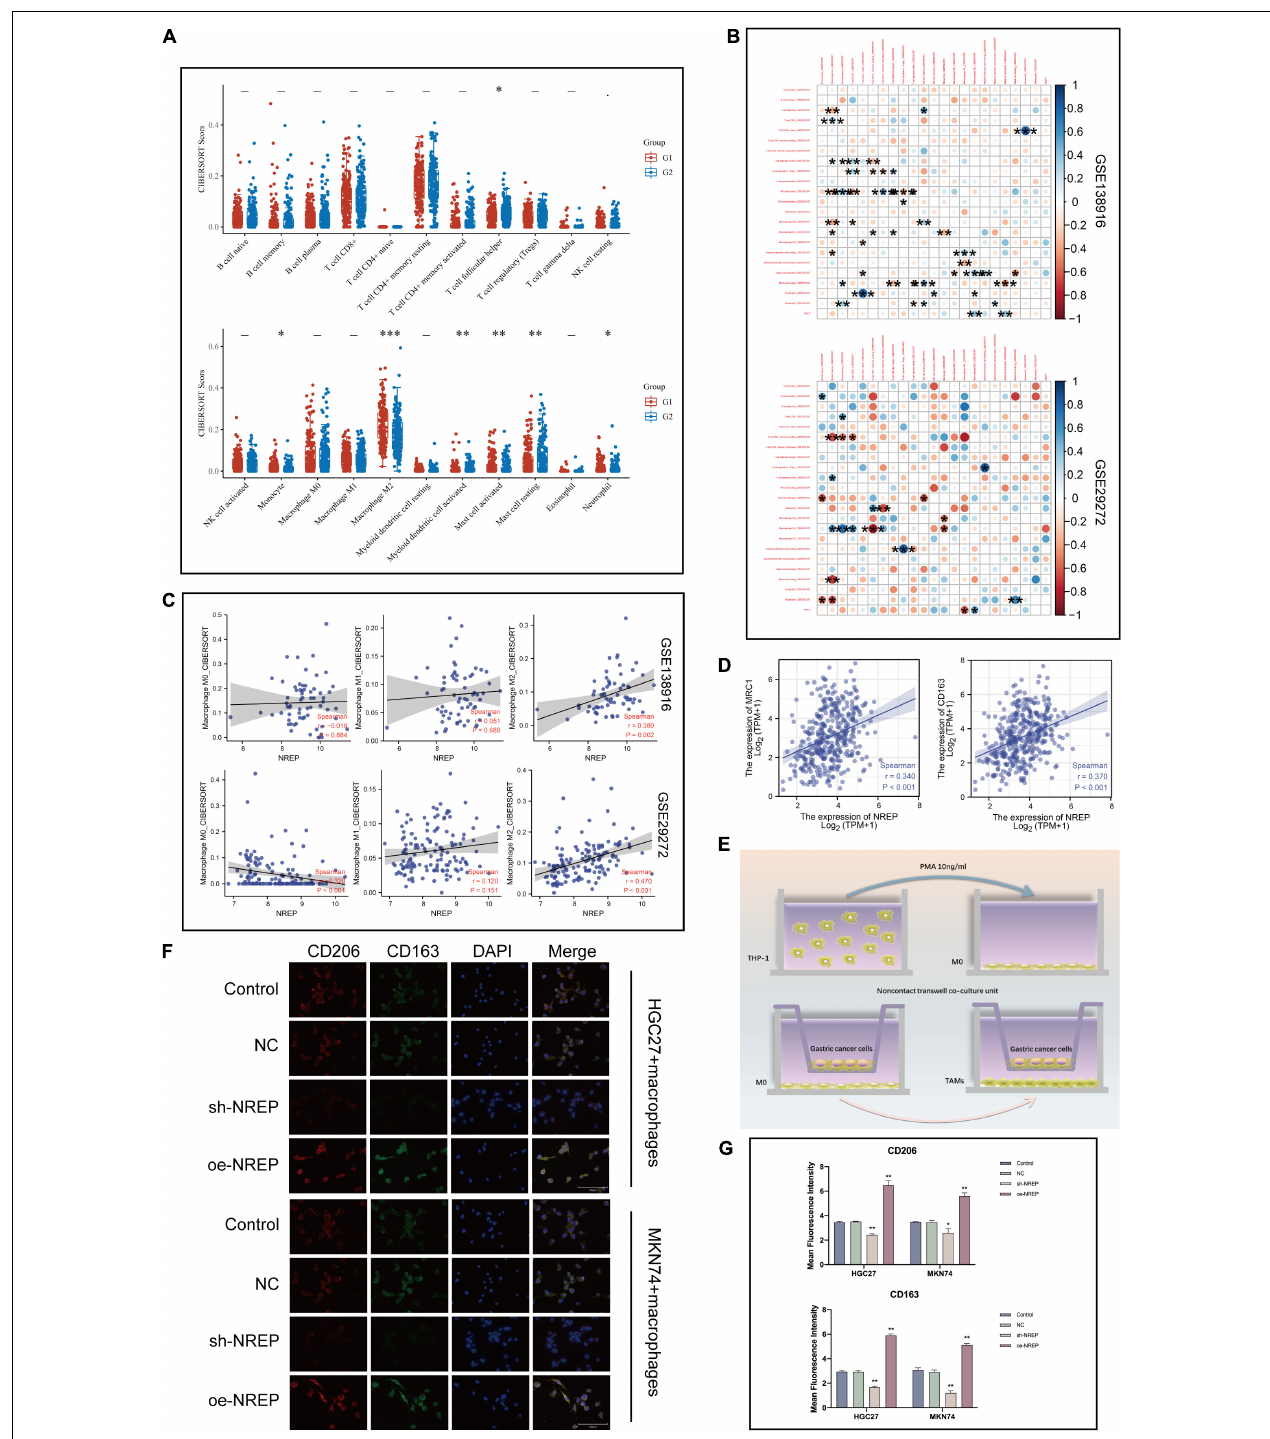
FIGURE 7 | Association of NREP expression with the abundance of M2 tumor-associated macrophage infiltration. (A) Score distribution of immune cells in gastric cancer (GC) and normal tissues. Horizontal axis, different groups; vertical axis, distribution of gene expression; G1, high NREP expression group; and G2, low NREP expression group. (B) Correlation matrix showing the abundance of 22 types of immune cells. (C) Correlation of NREP expression levels with macrophage abundance based on Fei et al., 2018 and Li et al, 2020 datasets. (D) Correlation of NREP expression levels with M2 macrophage markers. (E) Schematic diagram for the tumor–macrophage cell co-culture. (F) Immunofluorescence staining for CD206 (green) and CD163 (red; magnification, × 400). (G) Immunofluorescence expression. (* P < 0.05, ** P < 0.01, and *** P < 0.001).